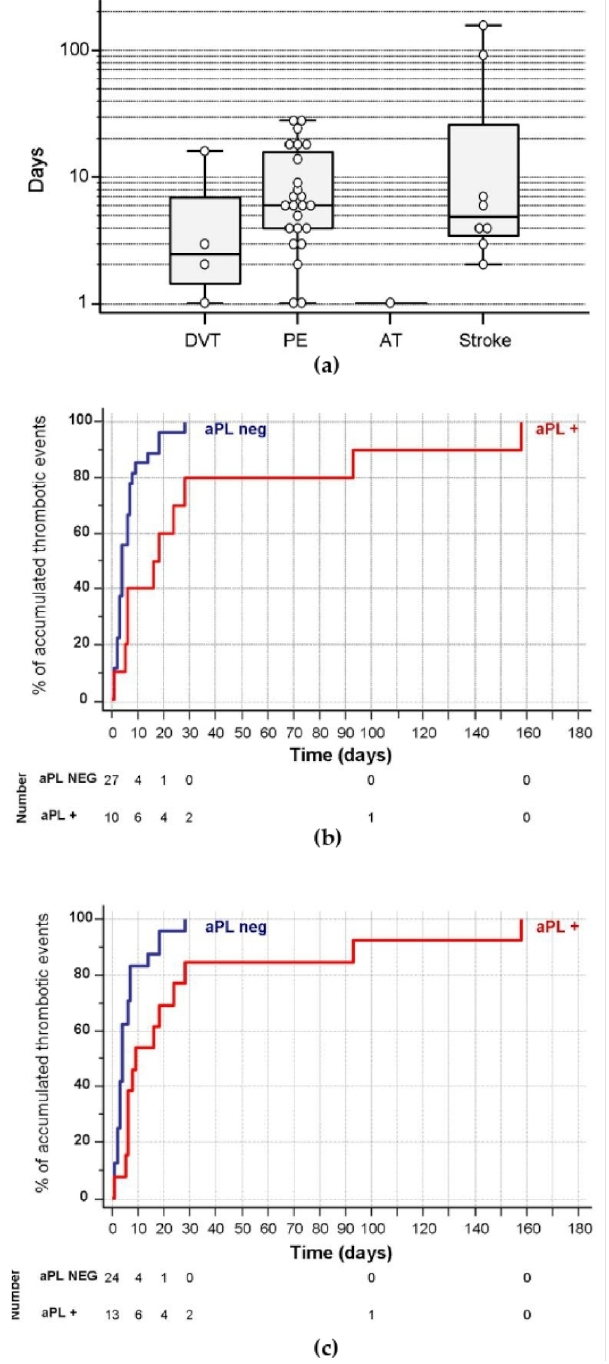
Figure 2. Days of appearance of thrombotic events counted from the day of hospital admission. ( a ). Depending on the type of event. ( b ). Time to onset of thrombotic events in patients who were positive (red) and negative (blue). ( c ). Time to onset of thrombotic events depending on aPL positivity in second sample. Red: aPL positive patients. The number at risk on the different days is indicated in the lower lines. DVT: Deep venous thrombosis. PE: Pulmonary embolism AT: Arterial